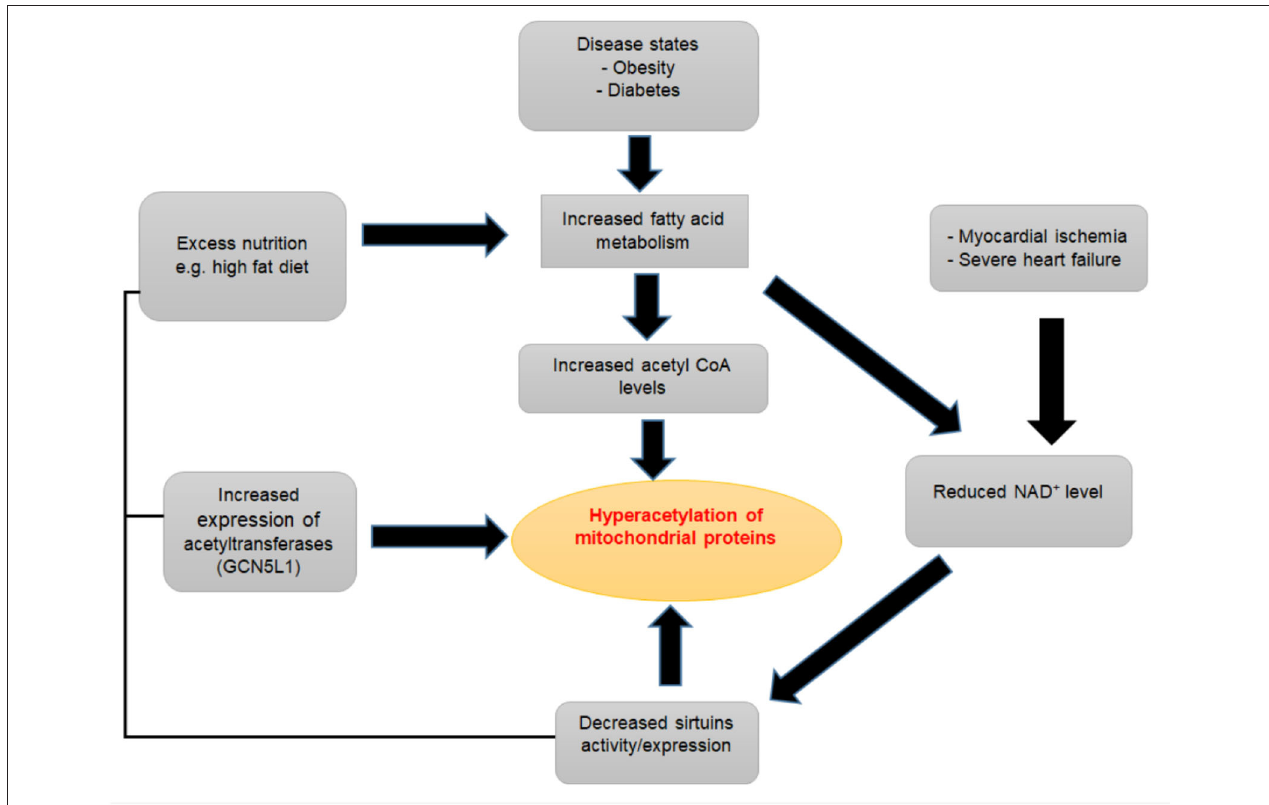
FIGURE 3 | Contributing factors to mitochondrial protein